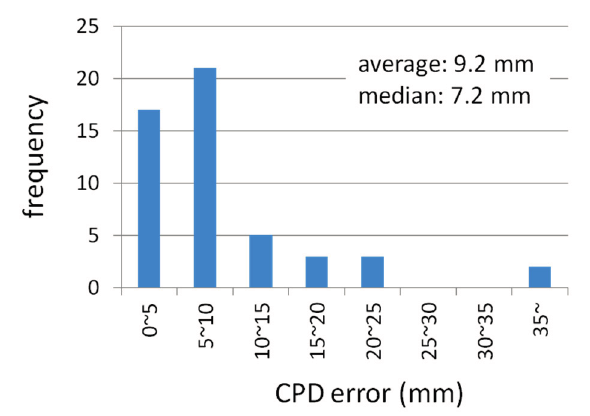
Figure 8. Estimated observation error of CPD: ( a ) meeting room and ( b ) corridor. (Unit is in millimeter)